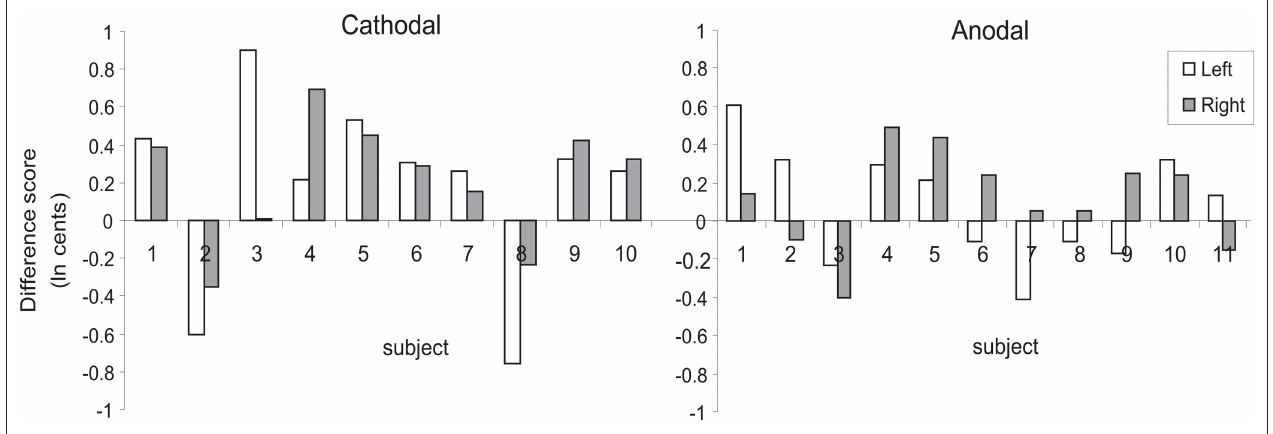
left-hemisphere stimulation; gray bars are difference scores following right-hemisphere stimulation. All data are in units of ln(cents), where 100 cents = 1